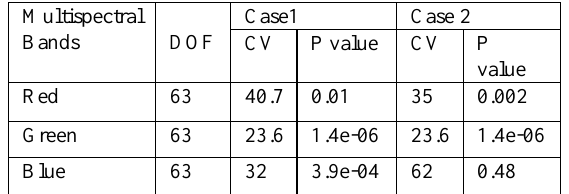
Table 4. Chi-square goodness of fit test between the data for the second